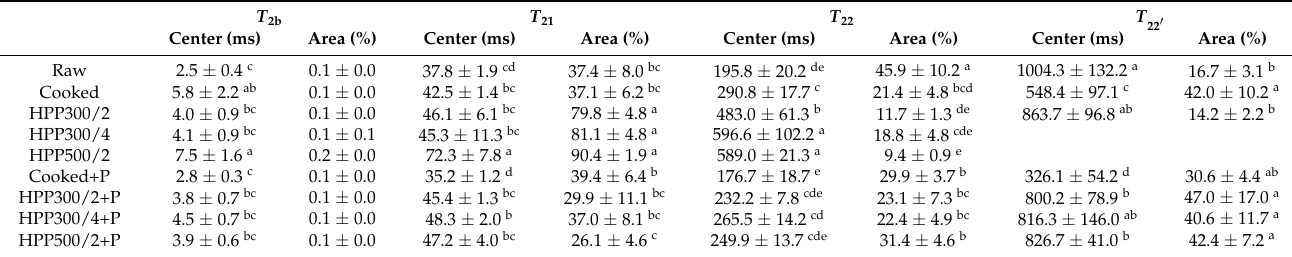
Table 2. Peak center (ms) and area proportion (%) of the water relaxation components from continuous distribution curves of transverse relaxation time ( T 2 ) obtained by LF-NMR analysis of meat extracted from raw (i.e., untreated) and processed edible crab